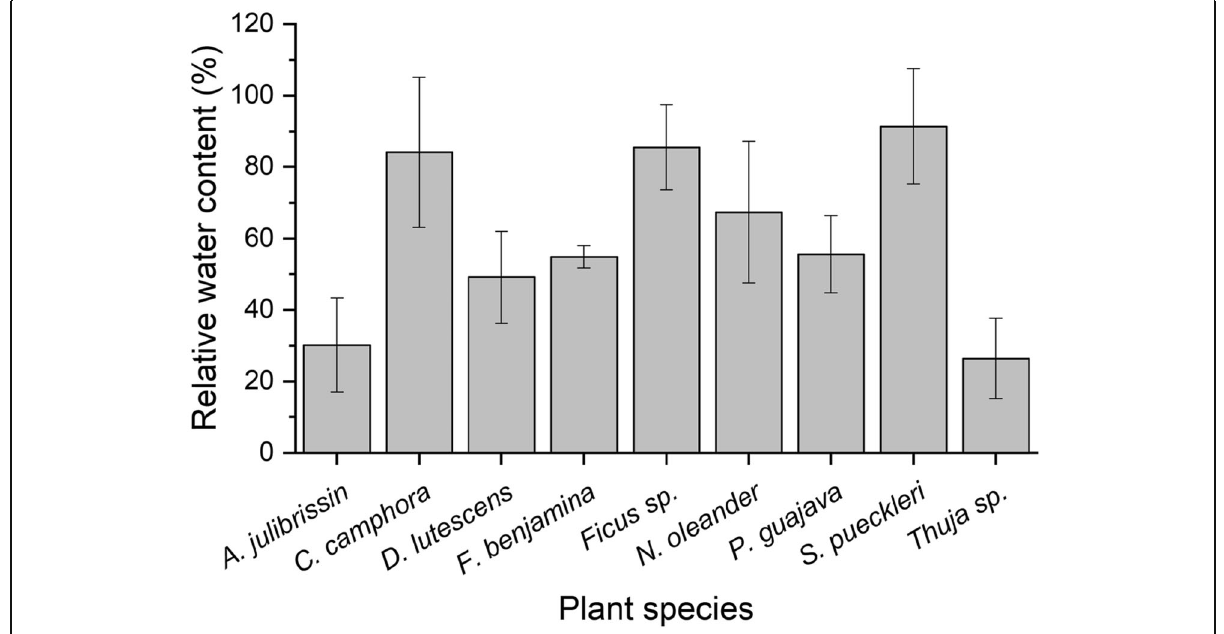
Fig. 2 Average relative water content of the selected plant species; error bars represent the standard deviation ( n = 6)